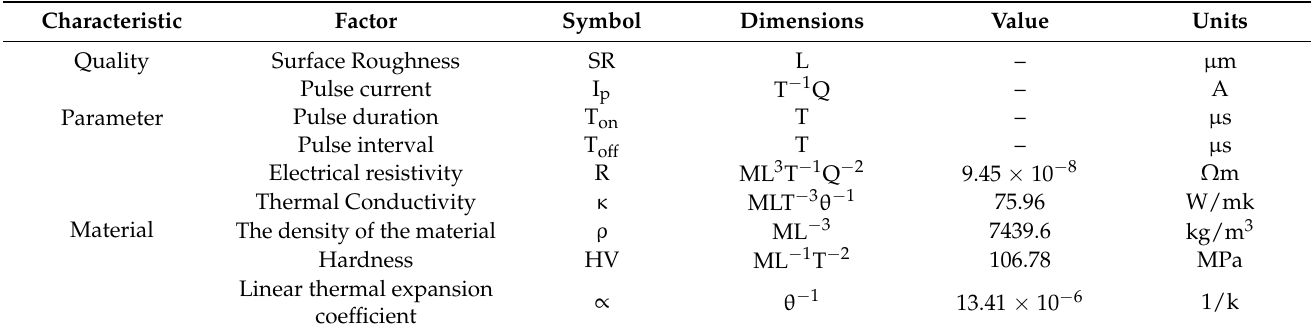
Table 5. Physical properties of various characteristics.